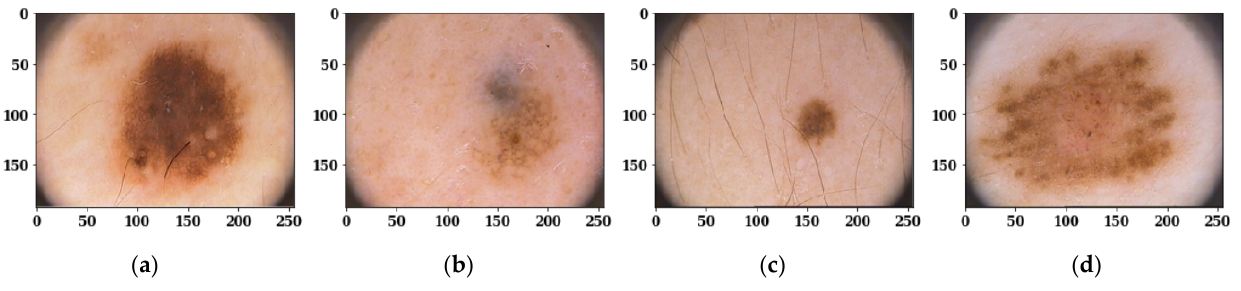
Figure 1. Skin Disease Original Images: ( a ) Image 1; ( b ) Image 2; ( c ) Image 3; ( d ) Image 4.